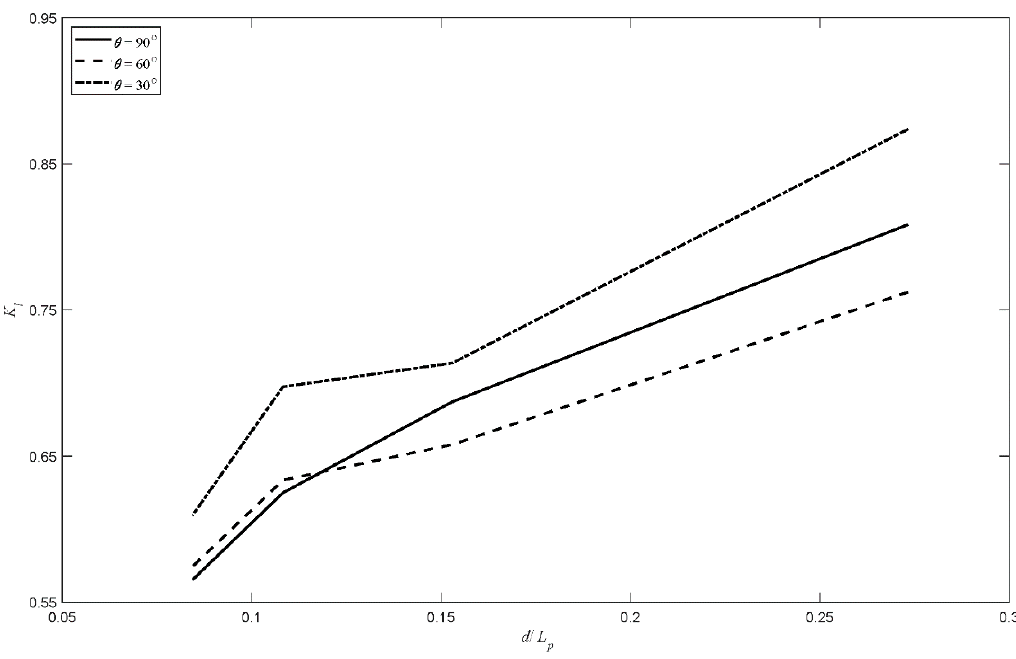
Figure 23. Effect of N on the variation of 𝐾 (cid:3039) with 𝑑 / 𝐿 (cid:3043) . P = 20%, θ = 60°, and 𝐻 (cid:3036)(cid:3046) / 𝑑 = 0.25.